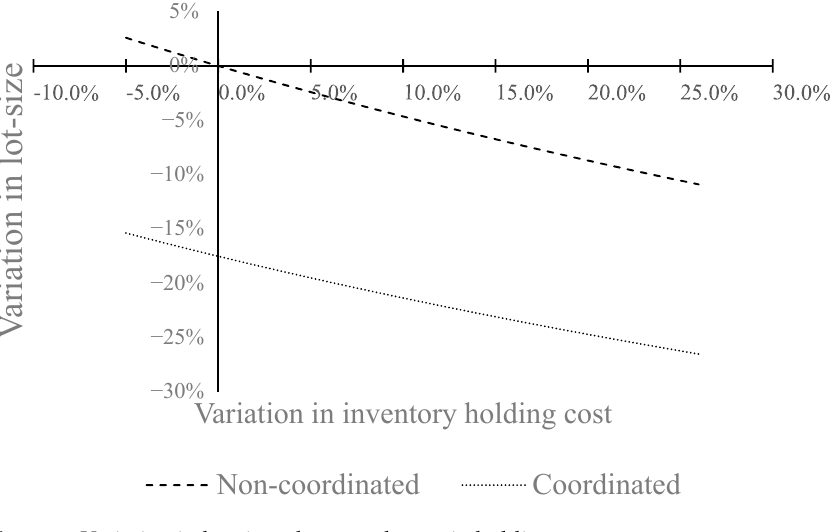
Figure 4. Variation in lot-sizes due to a change in holding cost.